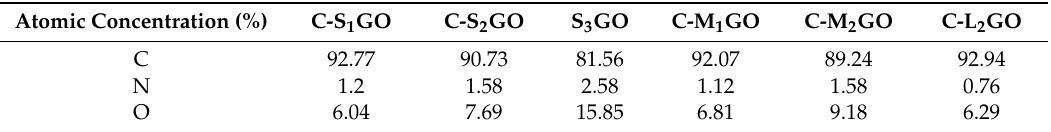
XPS analysis of the chemical composition of cross-linked graphene oxide powders using hydrazine.